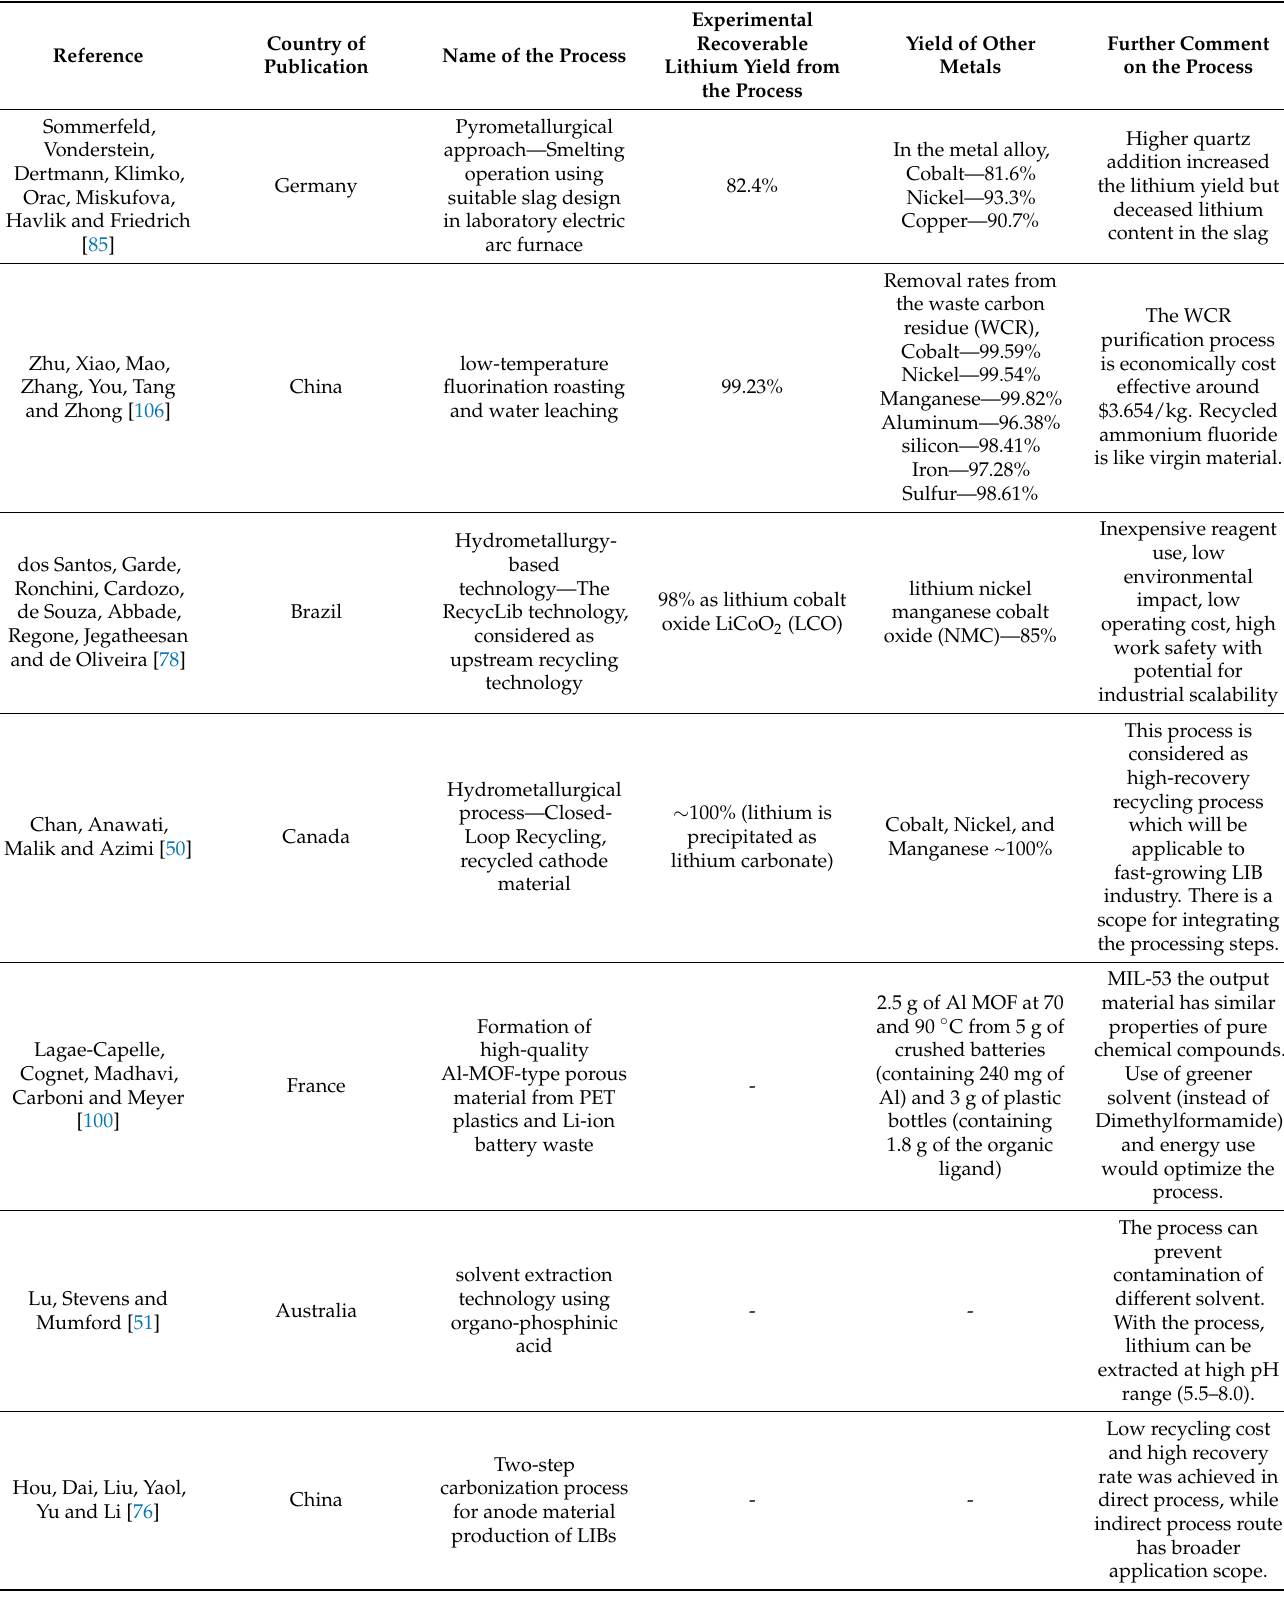
Table 4. Summary of the experimental studies on lithium-ion battery recovery and